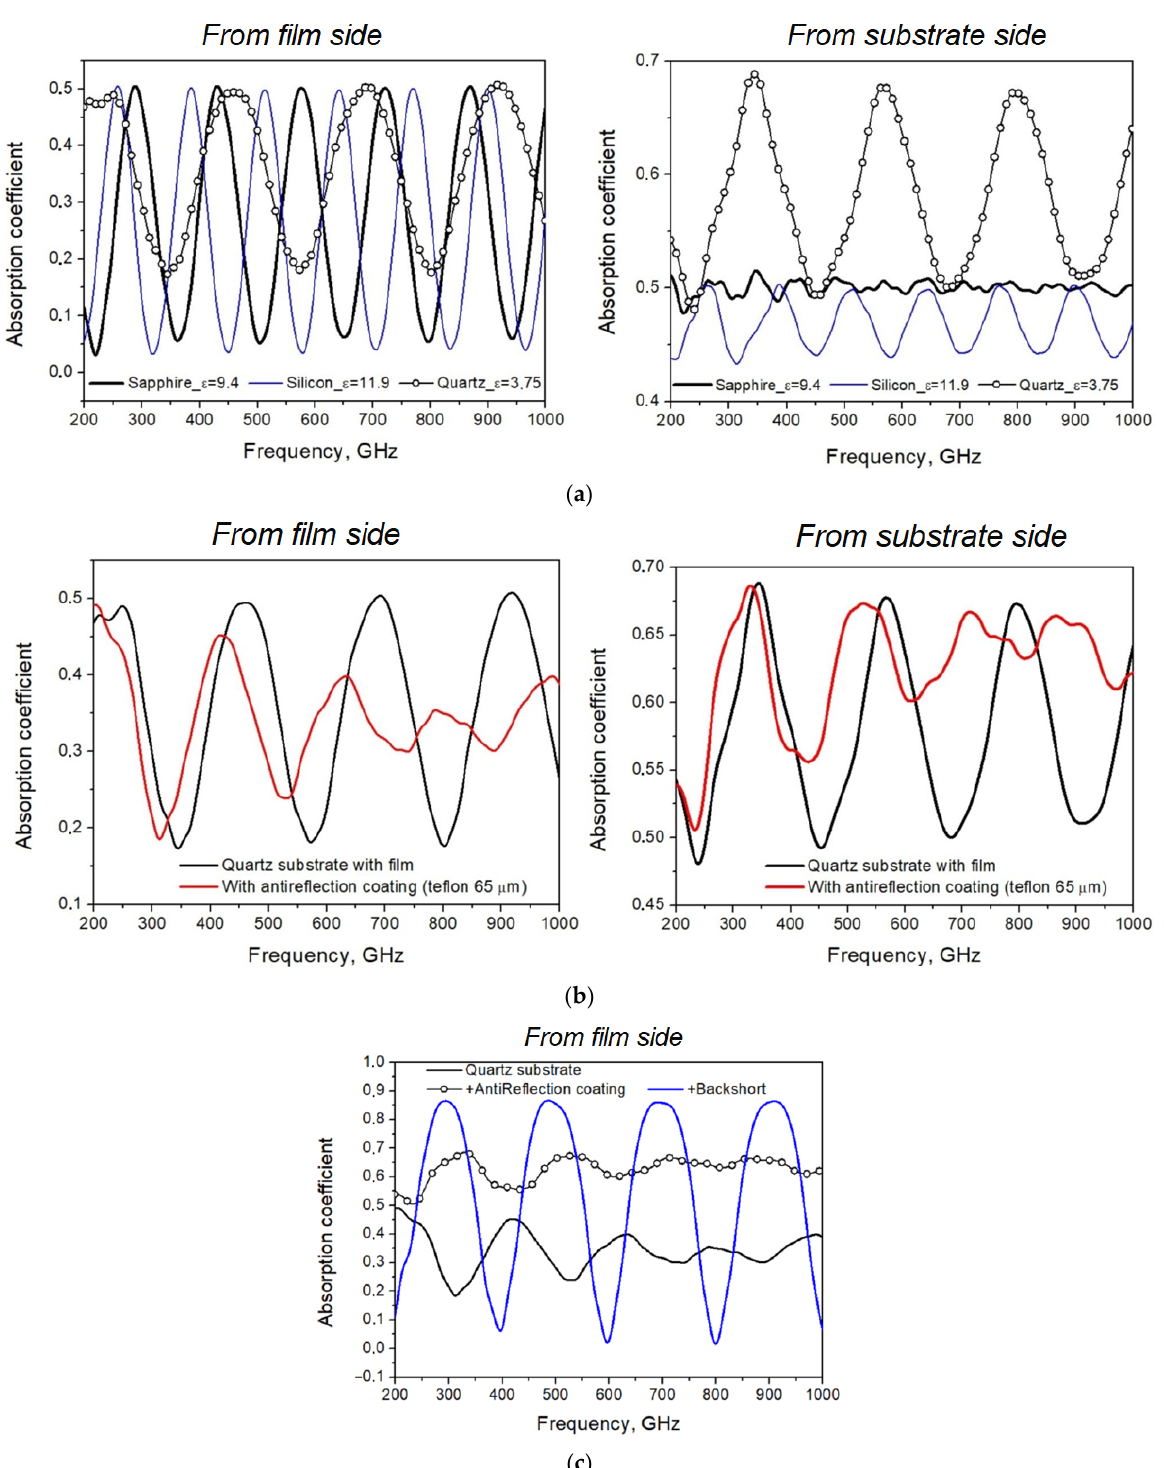
Figure 3. Modeled absorption coefficient of film with resistance of 188 Ω / □ on di ff erent substrates: ( a ) sapphire, silicon and quartz 340 μ m substrates, irradiation of film side ( left ) and substrate side ( right ); ( b ) quartz 340 μ m substrate with antireflection coating made of 65 μ m-thick Teflon, irradi- ation from film side ( left ) and substrate side ( right ); ( c ) comparison of results of modeling absorp- tion coefficient of thin film on quartz substrate without and with antireflection coating and with additional backshort behind antireflection coating .